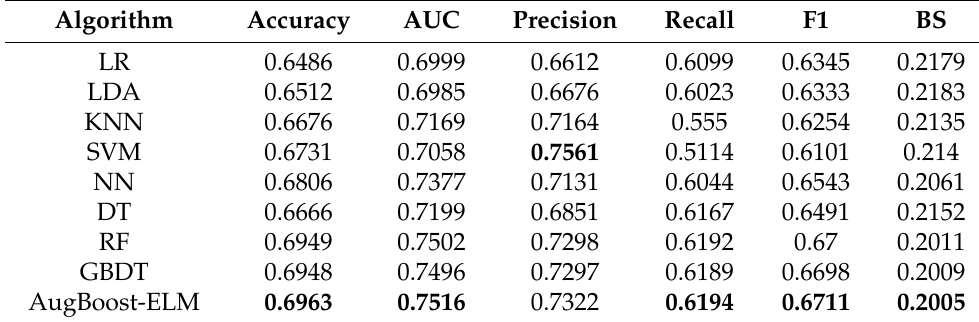
Table 7. Performance comparison of credit scoring models for the Taiwan